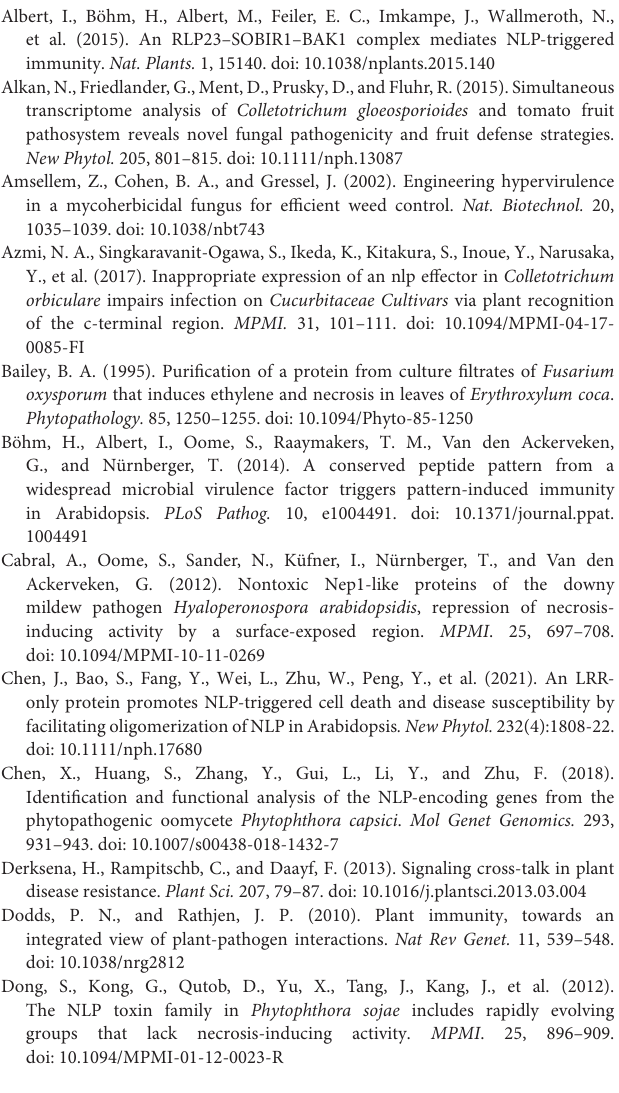
pEGAD-CgNLP1 indicates the tissue expressing recombinant vector pEGAD- CgNLP1 -eGFP. Supplementary Figure S4 | Identification of CgNLP1 transgenic Arabidopsis lines by Western blot. Col-0 indicates Arabidopsis Columbia-0, and 1-6 indicates different CgNLP1-OE transgenic lines under the Col-0 background. Supplementary Figure S5 | Alignment of HbMYB8-like and homologs from different plants. Shading indicated regions of conservation in all (black), the same amino acid as HbMYB8-like (gray) sequences. The protein sequences used for alignment are as follows: Arabidopsis thaliana AtMYB6 (EFH48703.1), Arabidopsis thaliana AtMYB8 (Q9SDS8.1), Oryza sativa OsMYB30 (Q6K1S6.1), Gossypium hirsutum GhMYB1 (NP_001313761.1), and Triticum aestivum TaRIM1 (AMP18876.1). Supplementary Figure S6 | Phylogenetic tree of HbMYB8-like with different types of MYB proteins in plants. Supplementary Table S1 | The primers used for PCR amplification quantitative and